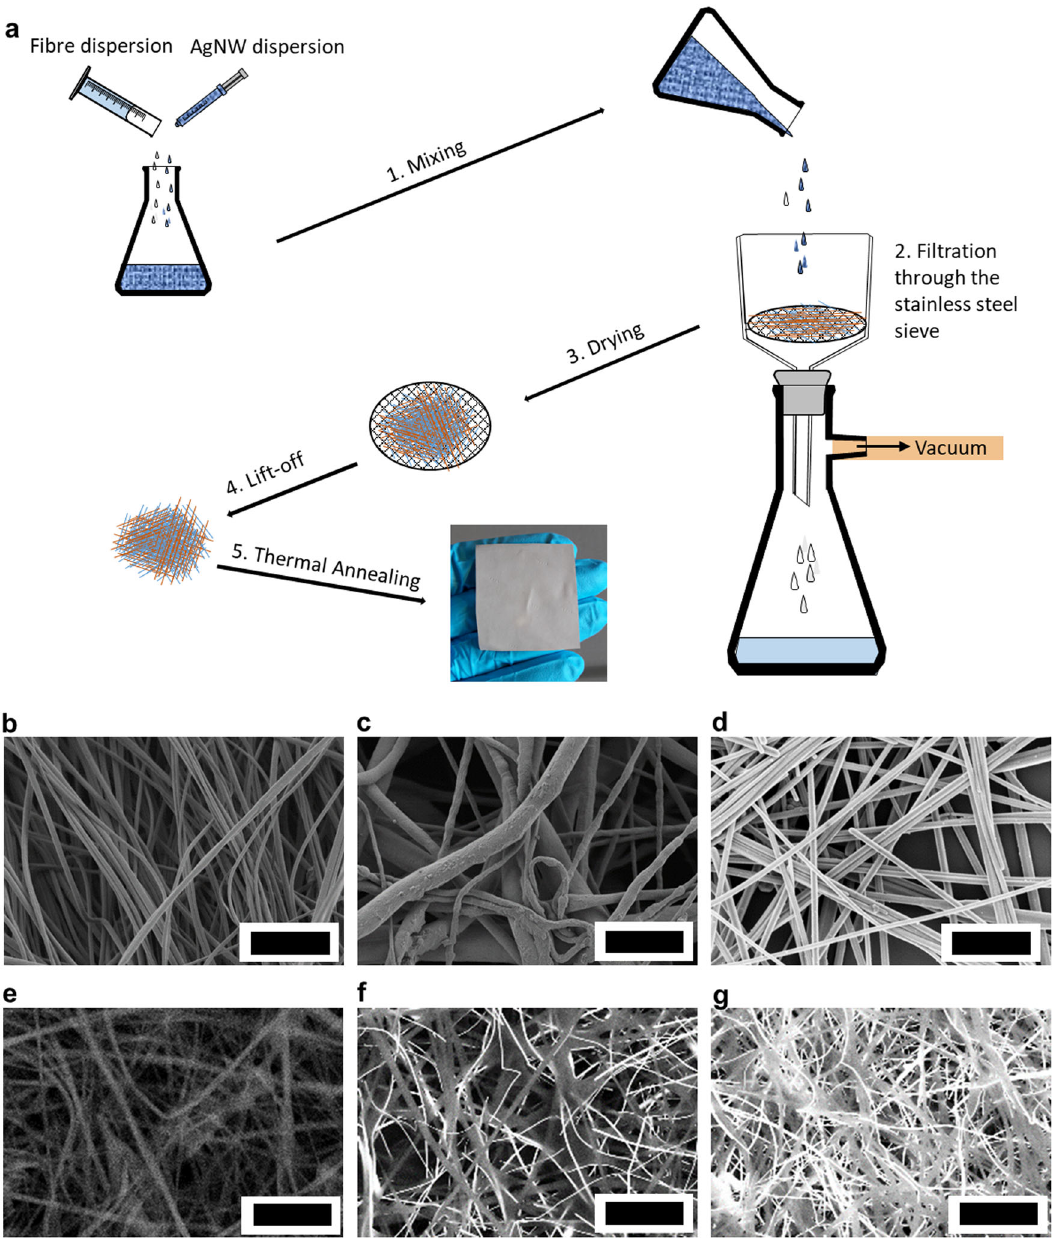
Fig. 1 Preparation and morphology of PAN/PCL/AgNW nonwovens prepared by the wet-laid process. a Schematic of the procedure for the preparation of the PAN/PCL/AgNW nonwovens. (1 – 5) 1 Mixing of PAN nano fi bres, PCL nano fi bres and AgNW. 2 Filtration of the PAN/PCL/ AgNW dispersion through the stainless steel sieve. 3 Drying of the PAN/PCL/AgNW nonwoven. 4 Lift-off of the PAN/PCL/AgNW nonwoven from the stainless steel sieve. 5 Thermal annealing of the PAN/PCL/AgNW nonwoven. SEM images of the polymeric and metallic fi bres: b As- electrospun PAN fi bres, c as-electrospun PCL fi bres, d AgNW; SEM/BSE images of the composite nonwovens with increasing AgNW content: e 0.00 vol%, f 0.36 vol% and g 1.07 vol%. scale bar 5 µm ( d 1